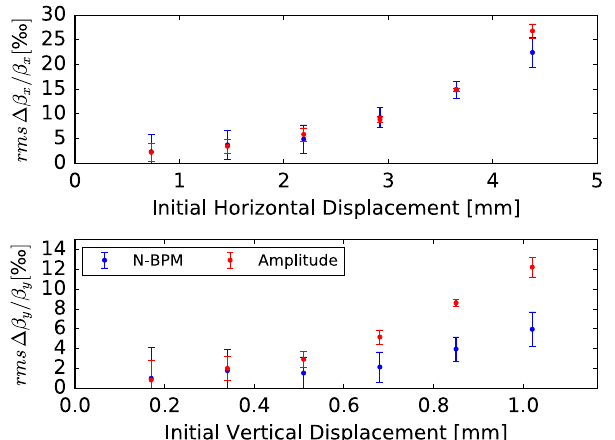
FIG. 5. Simulated rms of artificial β -beating computed by N-BPM and Amplitude methods from the same single-particle simulations with different diagonal initial displacement as in Fig. 4. The error bars refer to the mean (single-BPM) error bars averaged over all BPMs.